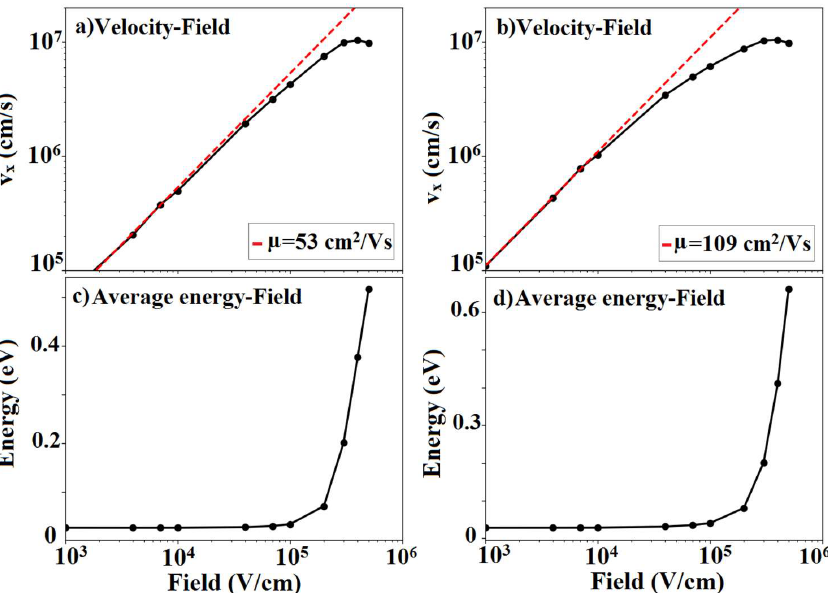
Figure 8. Velocity-field characteristics of ( a ) electrons and ( b ) holes. The average energy-field of ( c ) electrons and ( d ) holes in silicane calculated using the Monte Carlo method at room temperature (T = 300 K). Velocity saturation was observed at 3 × 10 5 V/cm and a negative slope of velocity-field was observed for fields exceeding 4 × 10 5 V/cm.